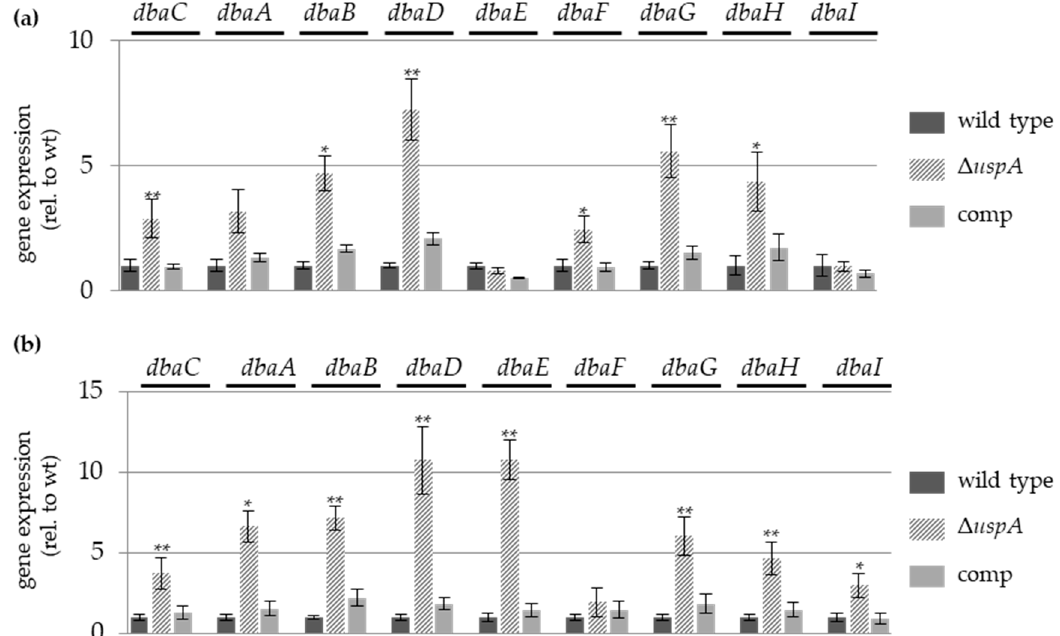
Figure 7. UspA represses the expression of the dba gene cluster. qRT-PCRs were performed for A. nidulans wild type, ∆ uspA, and the ectopic complementation (comp) strain. Mycelium of respective strains was transferred after 20 h of growth in submerged culture onto solid agar plates and incubated for 24 h in light ( a ) to induce asexual development or ( b ) 48 h in darkness to induce sexual development. Gene expression was normalized against h2A and 15S rRNA. Error bars represent the standard error of the mean of three biological and three technical replicates, each (* p ≤ 0.05; ** p ≤ 0.01).